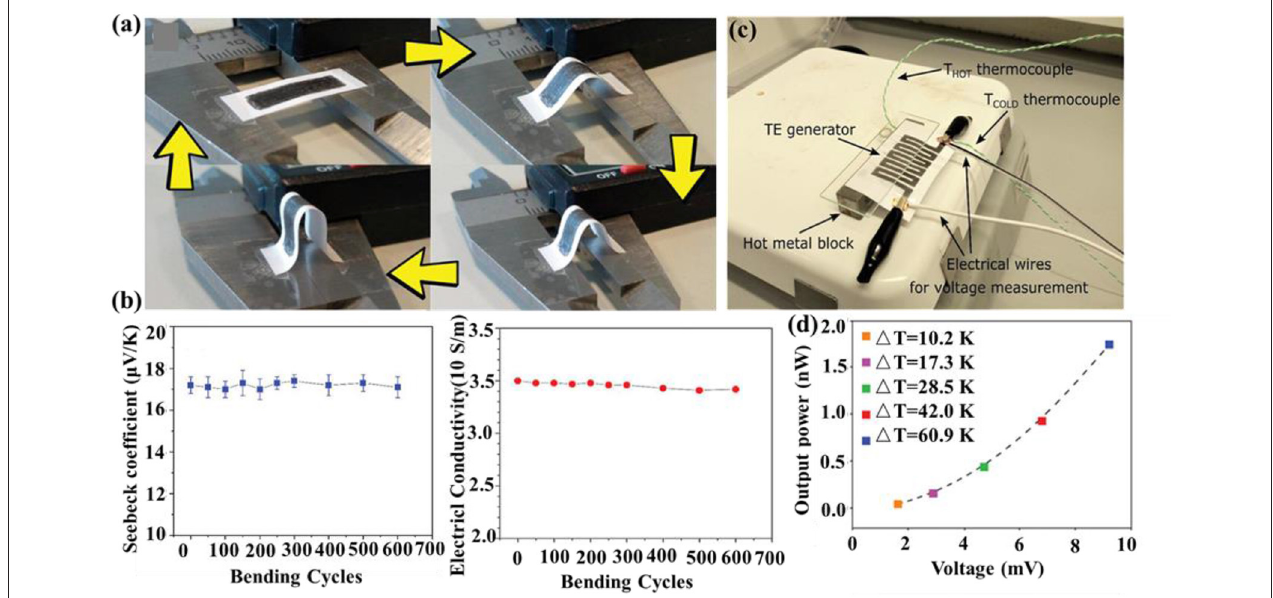
FIGURE 2 | (a) Photographs of the cyclical bending procedure applied to the thermoelectric trace with individual p-type and n-type graphite traces and (b) Seebeck coefficient (left) and electrical conductivity (right) over multiple bending cycles. (c) Photograph of the setup used for electrical testing of the thermoelectric generator (TEG) module using graphite and polyethylenimine and (d) the corresponding power output vs. voltage with respect to 1 T. Reproduced with